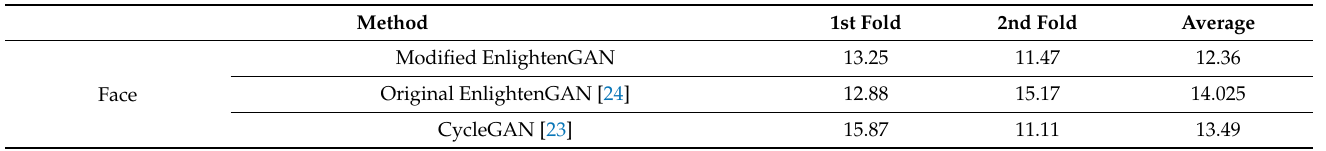
Table 15. Comparisons of EERs obtained using our proposed method with those obtained using state-of-the-art GAN-based methods (unit: